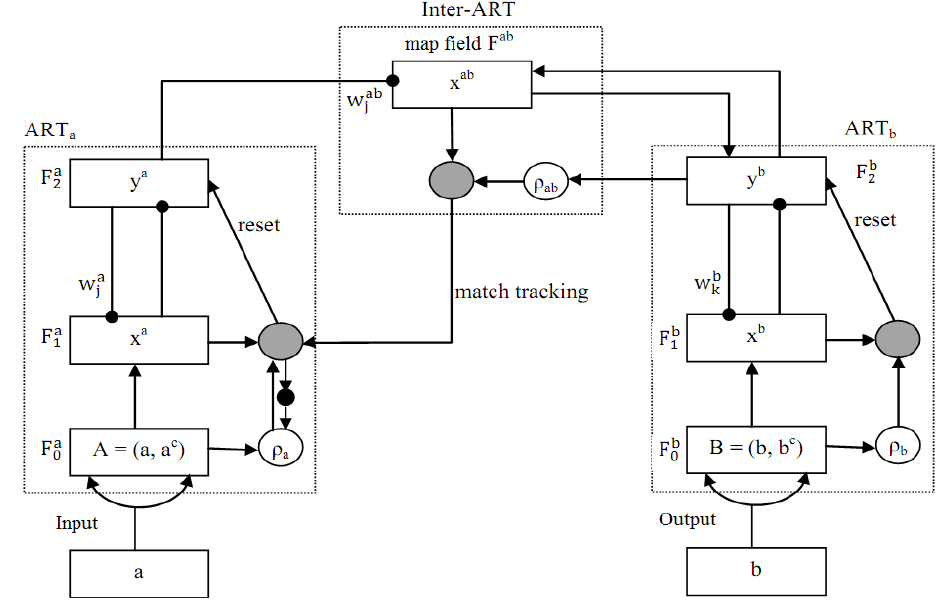
Figure 7. FAM Architecture.